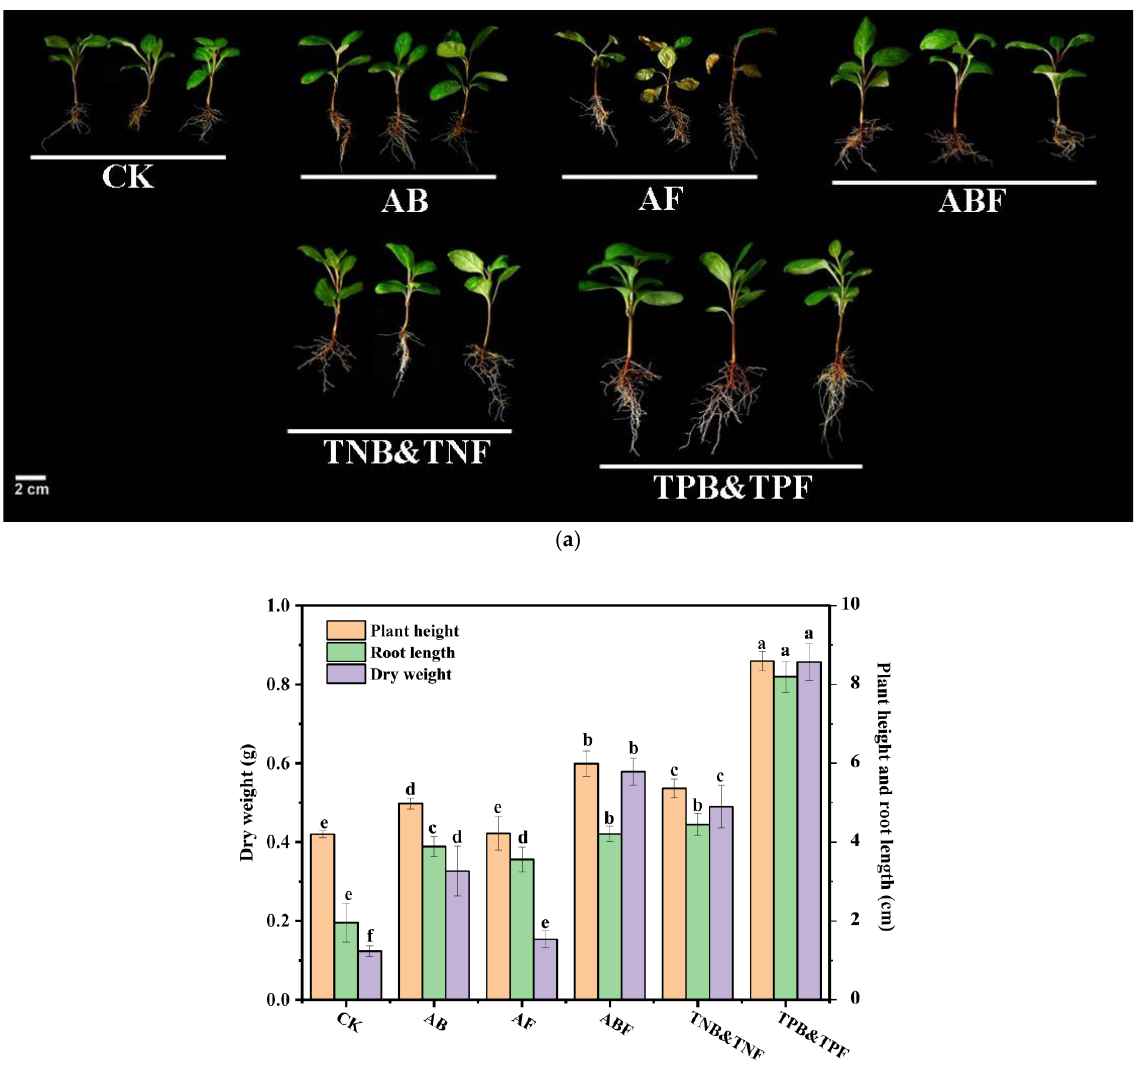
Figure 7. Pot experiment of SynCom in germ-free S. sphenanthera plants. ( a ) Growth status of S. sphenanthera in different treatment groups. ( b ) Effects of different SynComs on root length, stem length, and dry weight of S. sphenanthera . Different lowercase letters (a–f) indicate significant differences between different treatments, one-way ANOVA, Duncan’s test. Error bars represent the SEM.